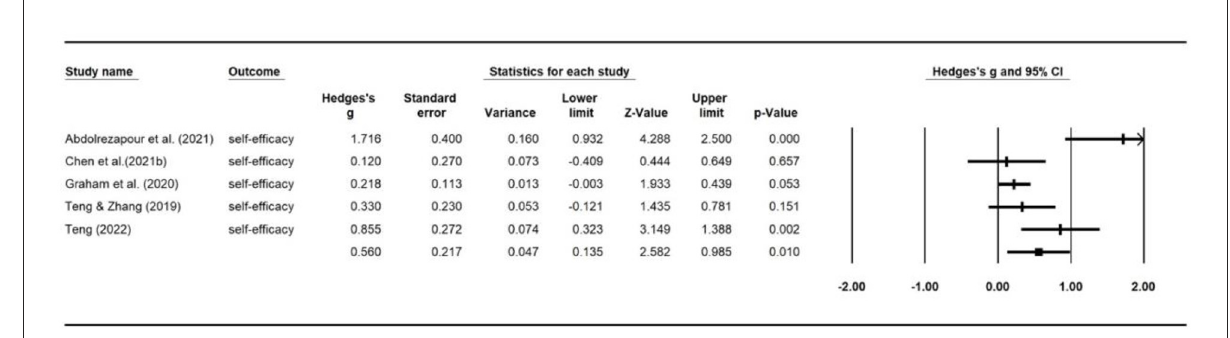
FIGURE8 Forest plot of overall effect size estimates for self-efficacy.